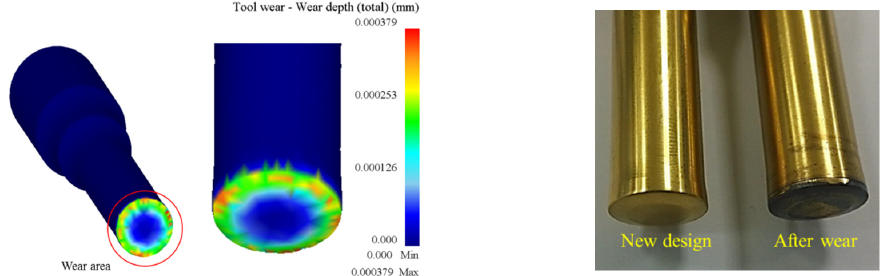
Figure 17. Wear of optimized simulated and actual upper punches.